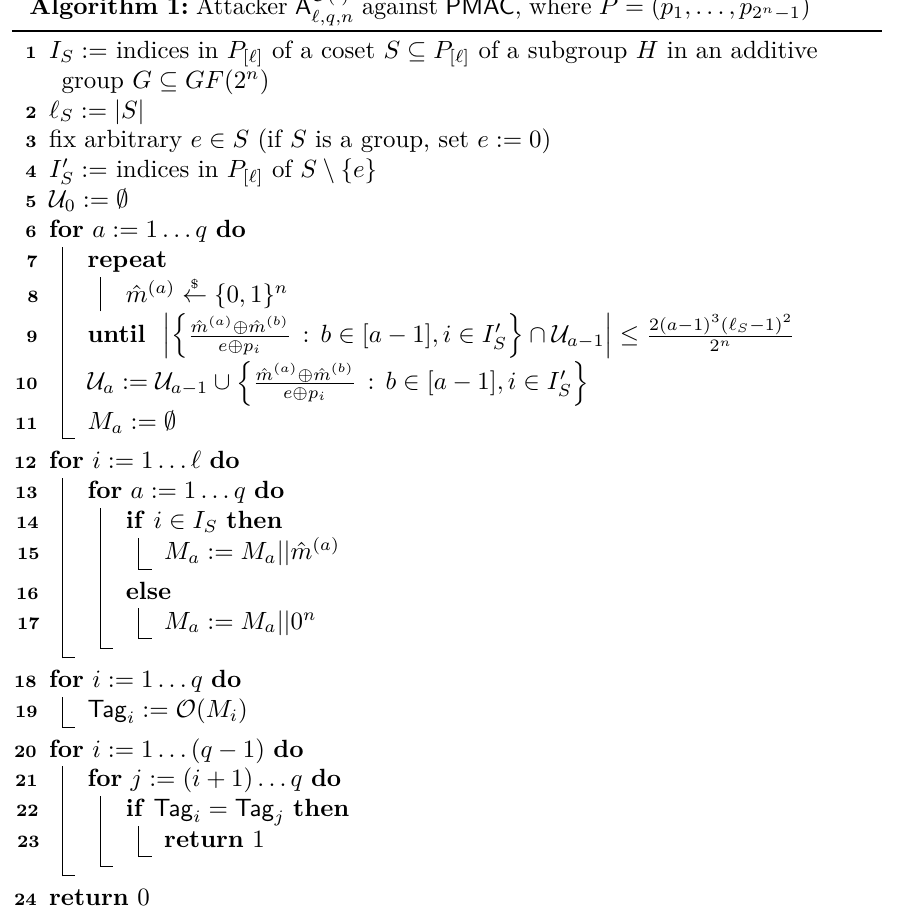
Algorithm 1: Attacker A O ( · )